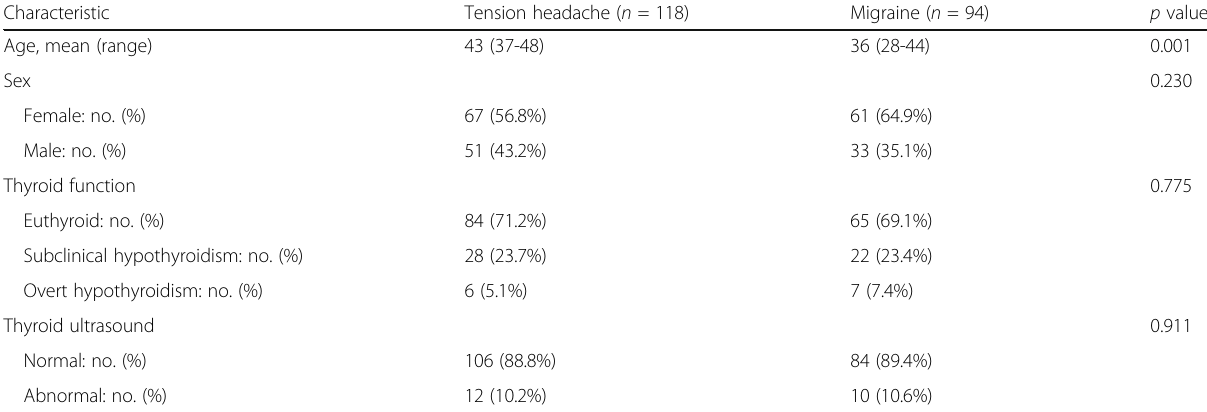
Table 4 Age, gender, and thyroid profile between tension headache and migraine Characteristic